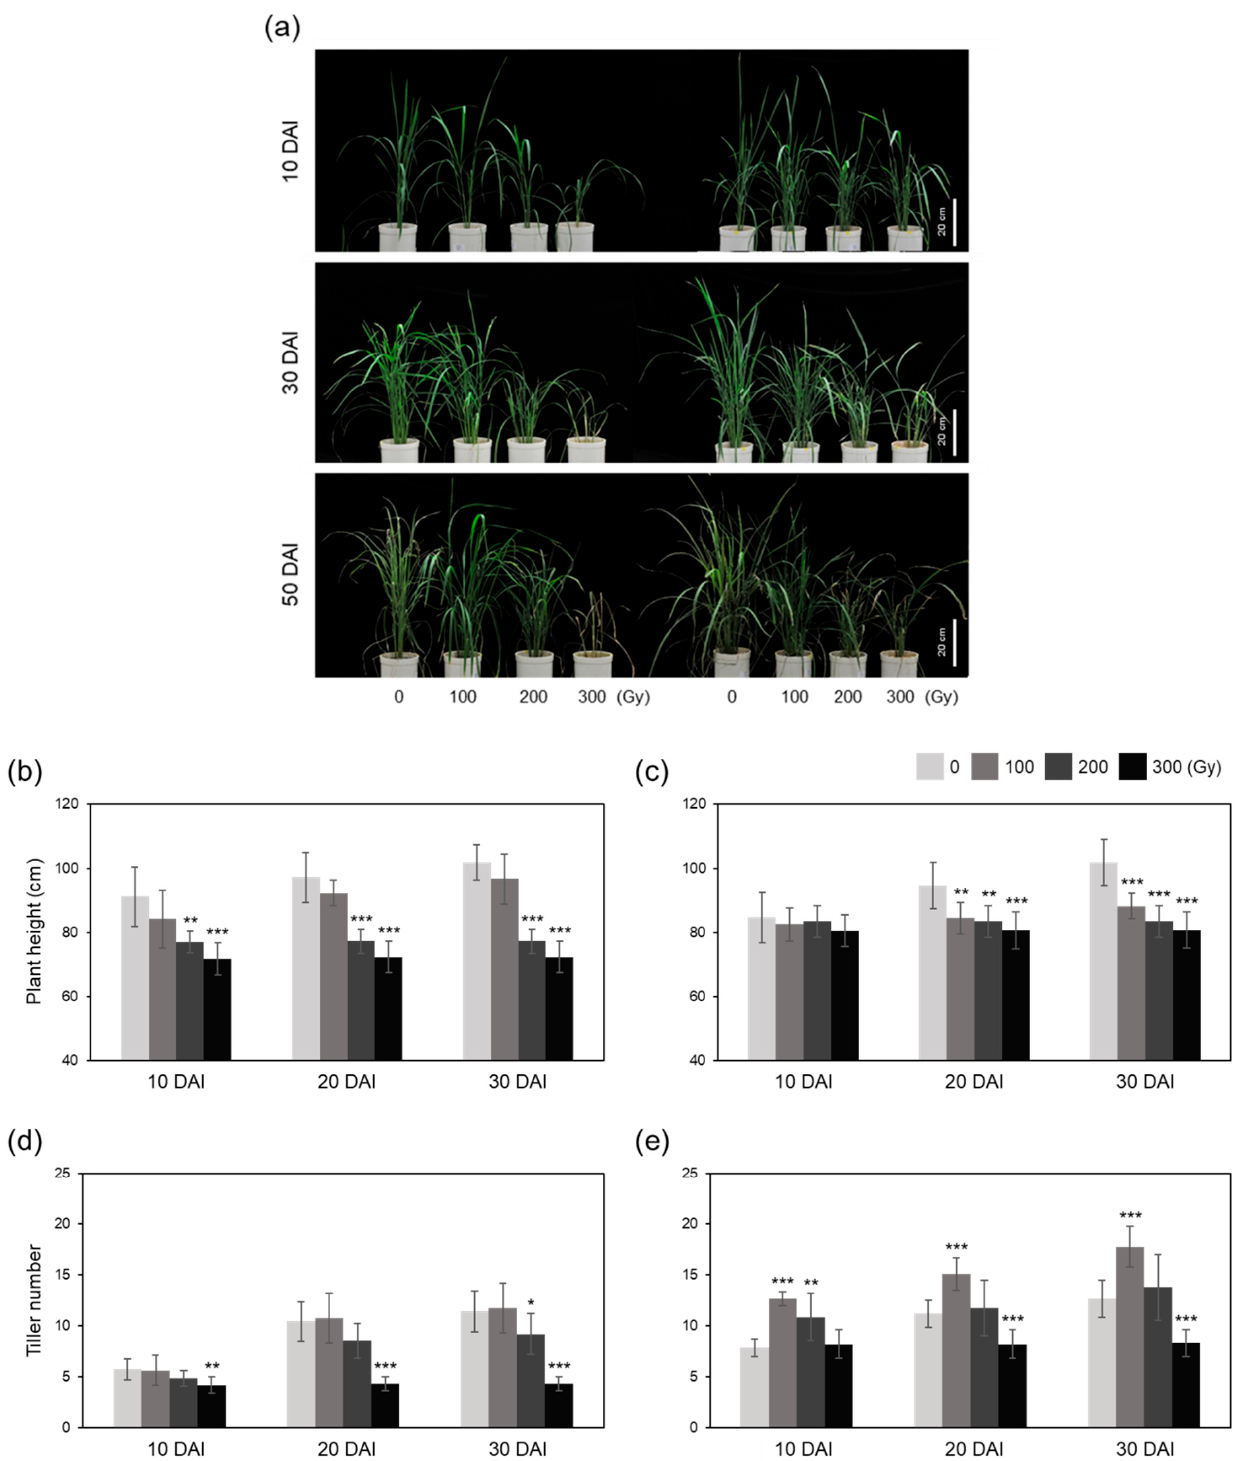
Figure 8. Growth analysis of rice plants exposed to gamma irradiation. ( a ) Photographs of rice plants treated with acute and chronic gamma irradiation. ( b – e ) Plant height ( b , c ) and tiller number ( d , e ) of rice plants subjected to acute ( b , d ) and chronic ( c , e ) gamma irradiation. DAI, days after irradiation. Data represent mean ± SD. Asterisks indicate significant differences between control (0 Gy) and other treatments (* p < 0.05, ** p < 0.01, *** p < 0.001). We also surveyed the panicle number (PN), panicle length (PL), spikelet number per panicle (SN), and fertility rate (FR) of rice plants to evaluate the effects of gamma irradia- tion on reproduction in rice plants. The results showed that both acute and chronic irra- diation negatively affected plant reproduction (Table 1). The A-100 treatment showed a